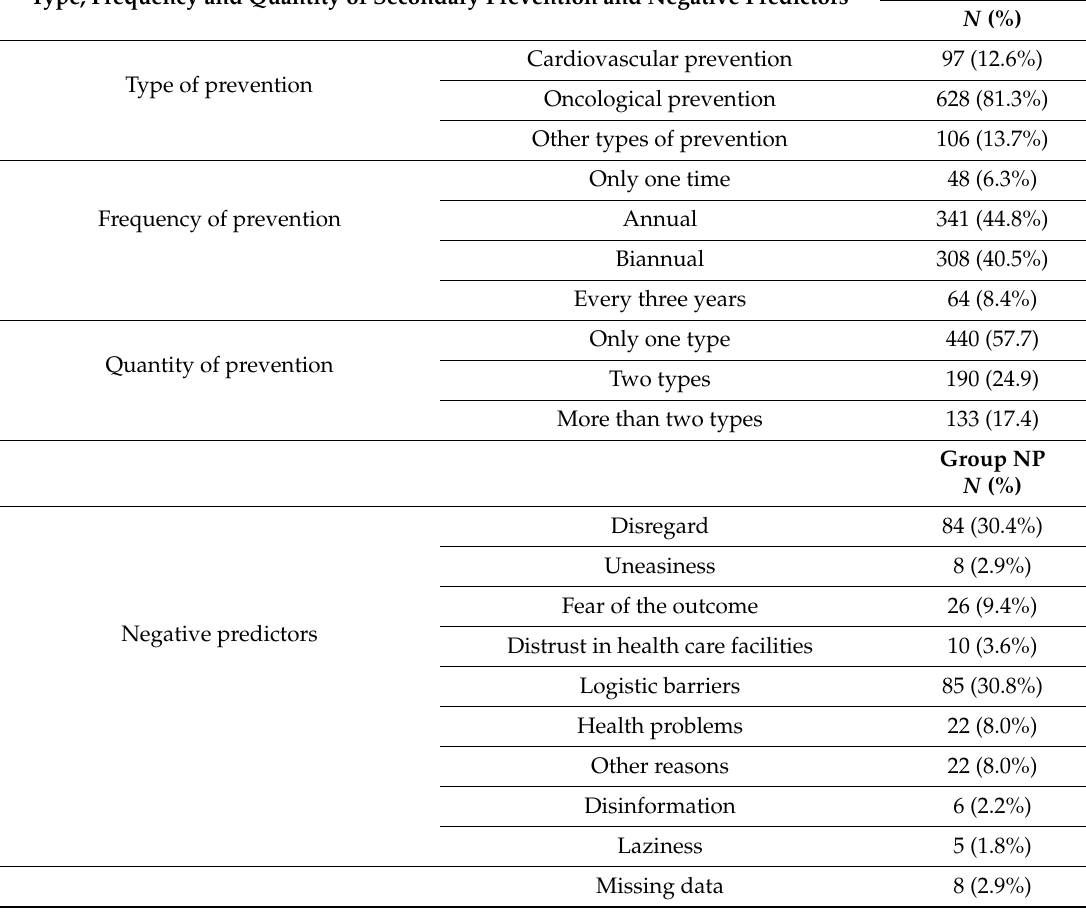
Table 2. Type of secondary prevention and negative